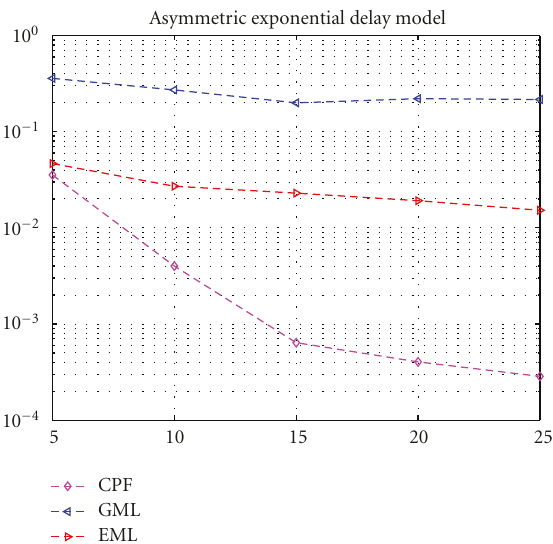
Figure 2: MSEs of clock o ff set estimators for asymmetric Exponen- tial random delays [ λ 1 = 1, λ 2 = 5].